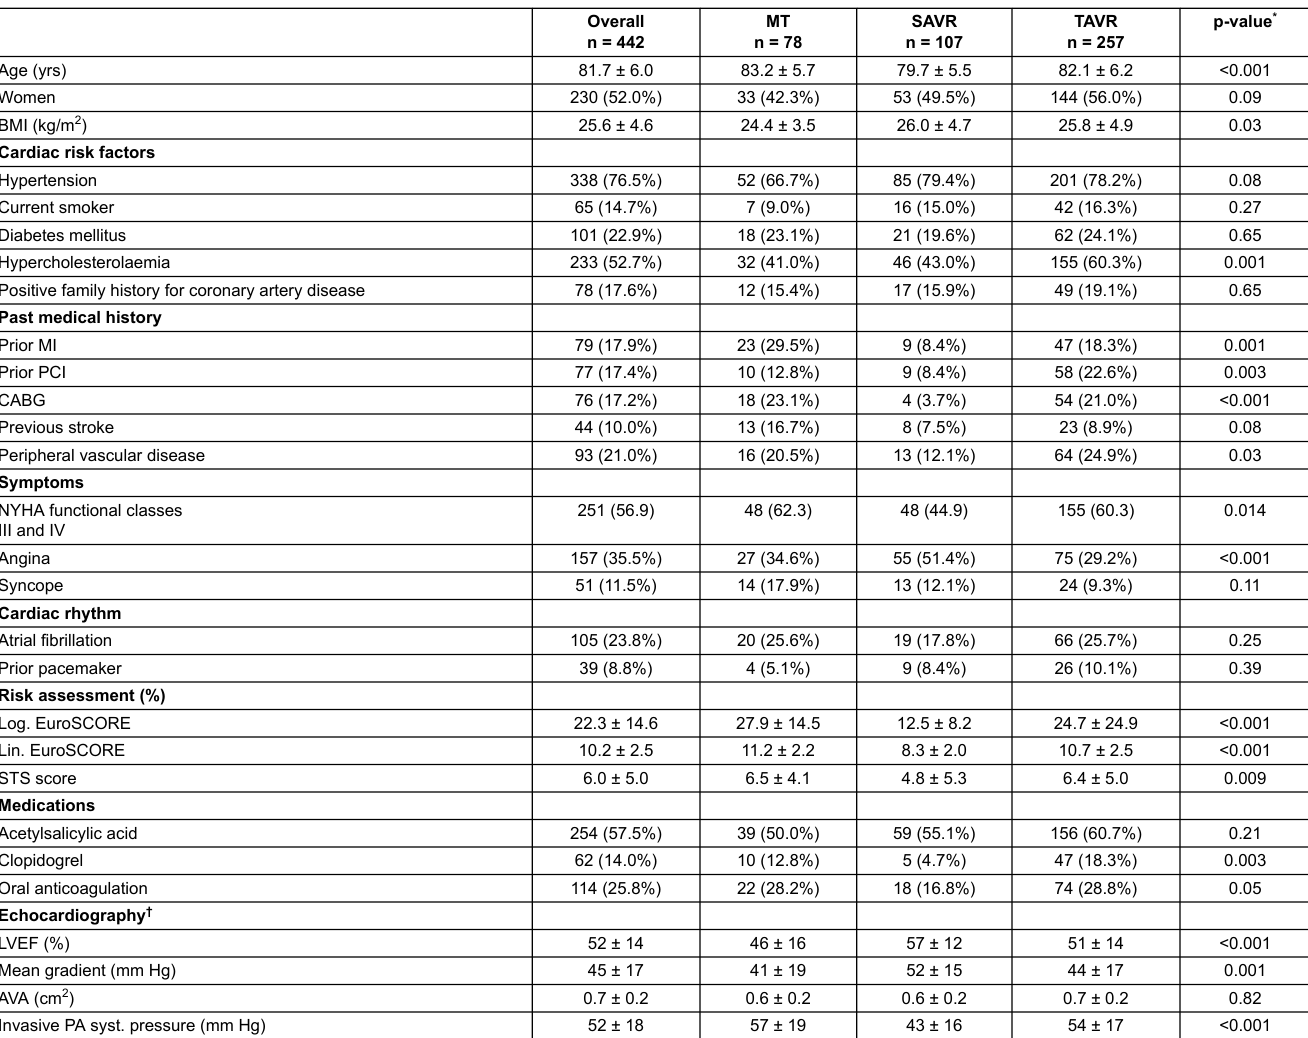
Table 1: Baseline characteristics.